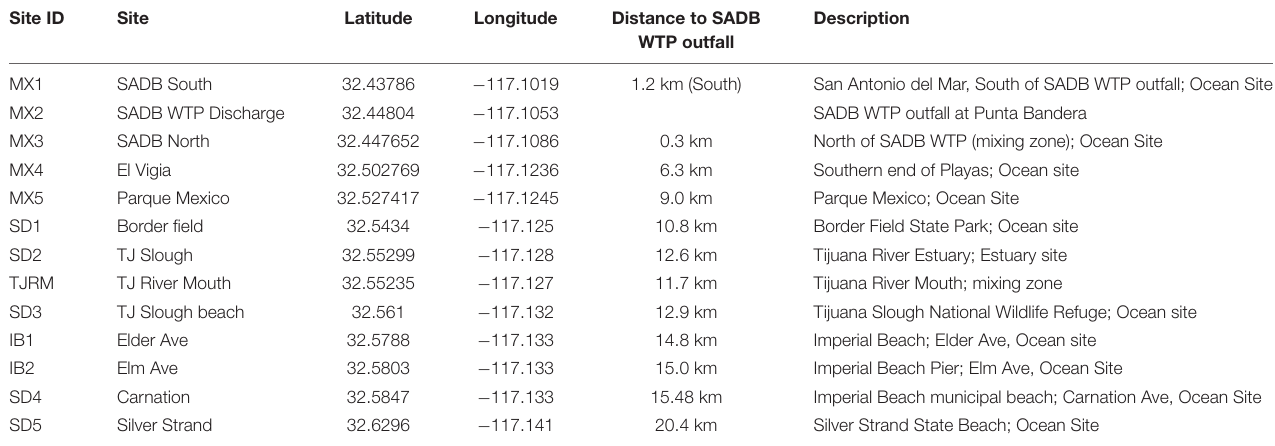
TABLE 1 | Description of sampling